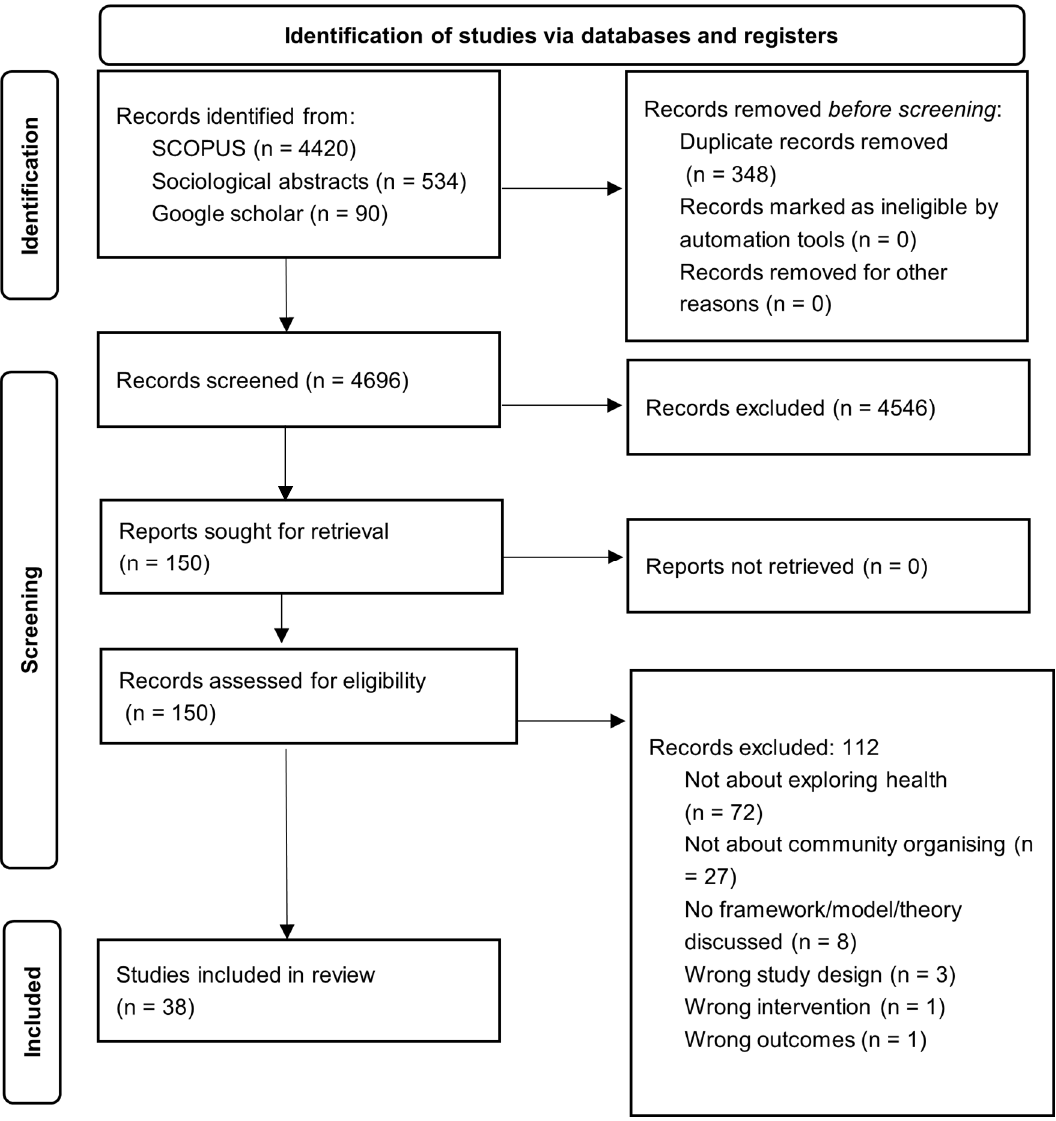
Figure 1. PRISMA flowchart detailing the article selection process for the scoping review .